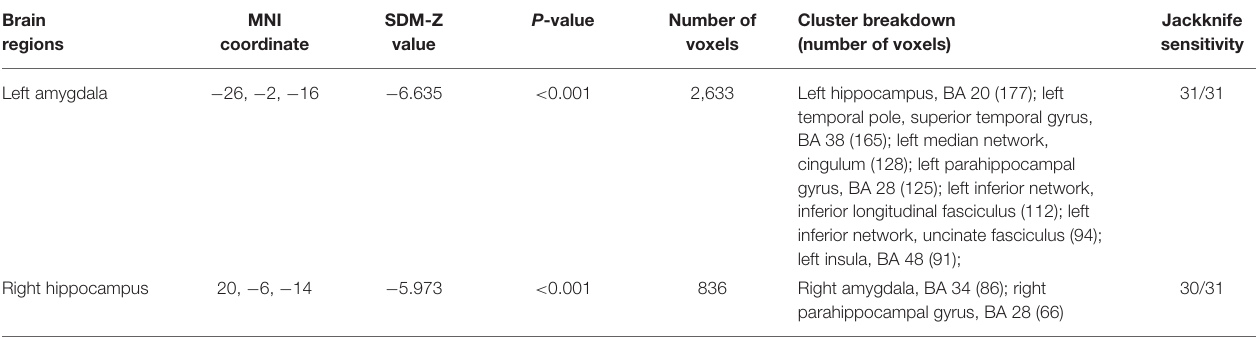
TABLE 2 | Regional differences in GM volume between patients with aMCI and healthy controls in the meta-analysis. Brain